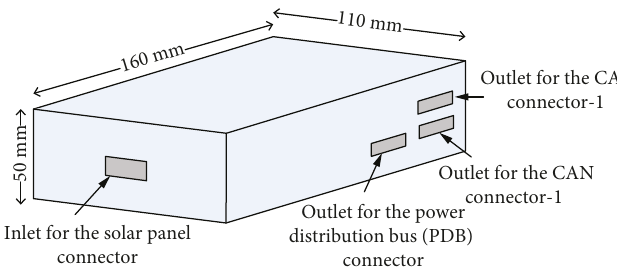
Figure 3: Casing dimensions of the PCM.